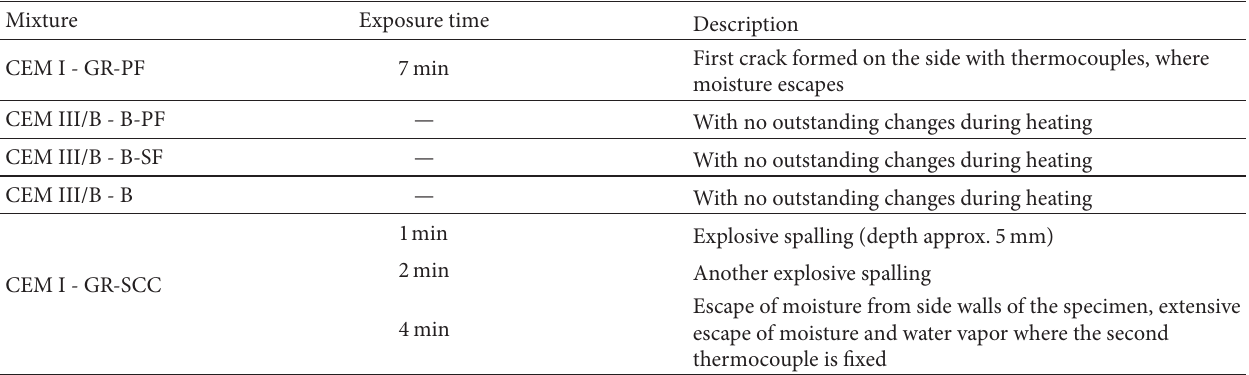
Table 4: Description of individual specimens during heating.